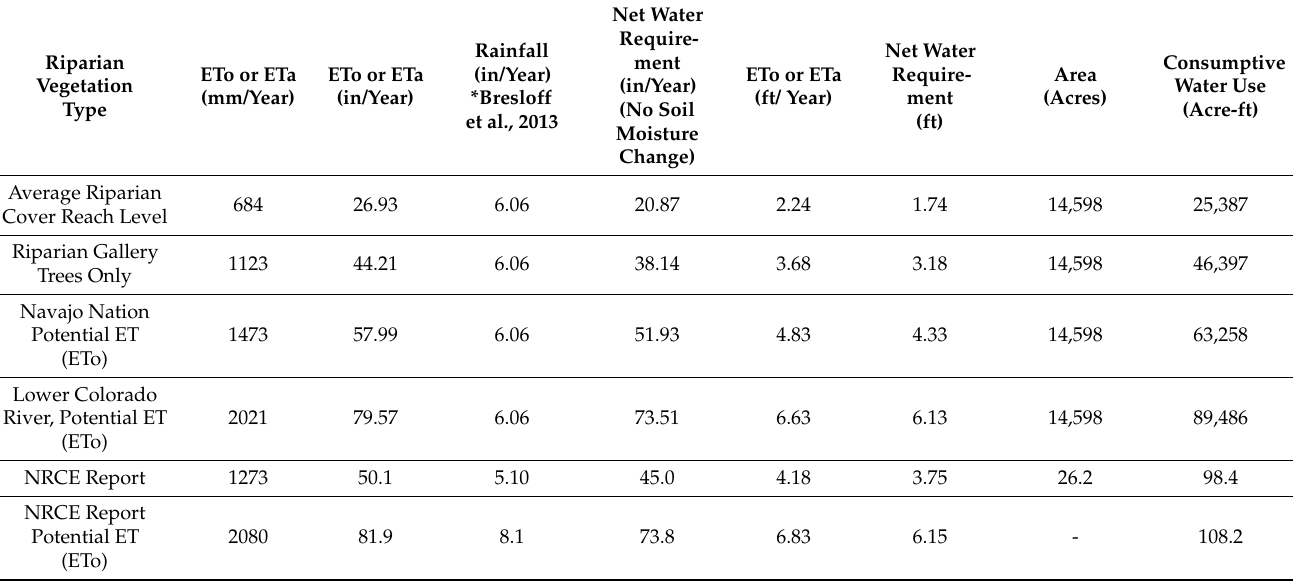
Table 3. Reproduced literature-based riparian water metric estimates for different vegetation density, cover and ETo (shaded green) from various study sites in Arizona [32] for comparison to estimed data (this report) for ETo, ETa, PP, WD and